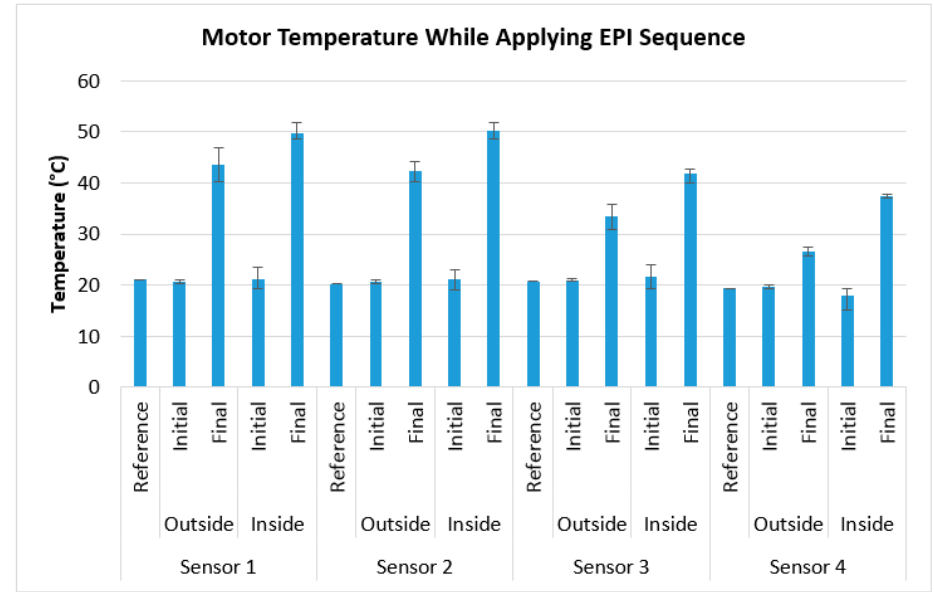
Figure 7. Motor temperature increase while applying Echo Planar Imaging (EPI) sequences.